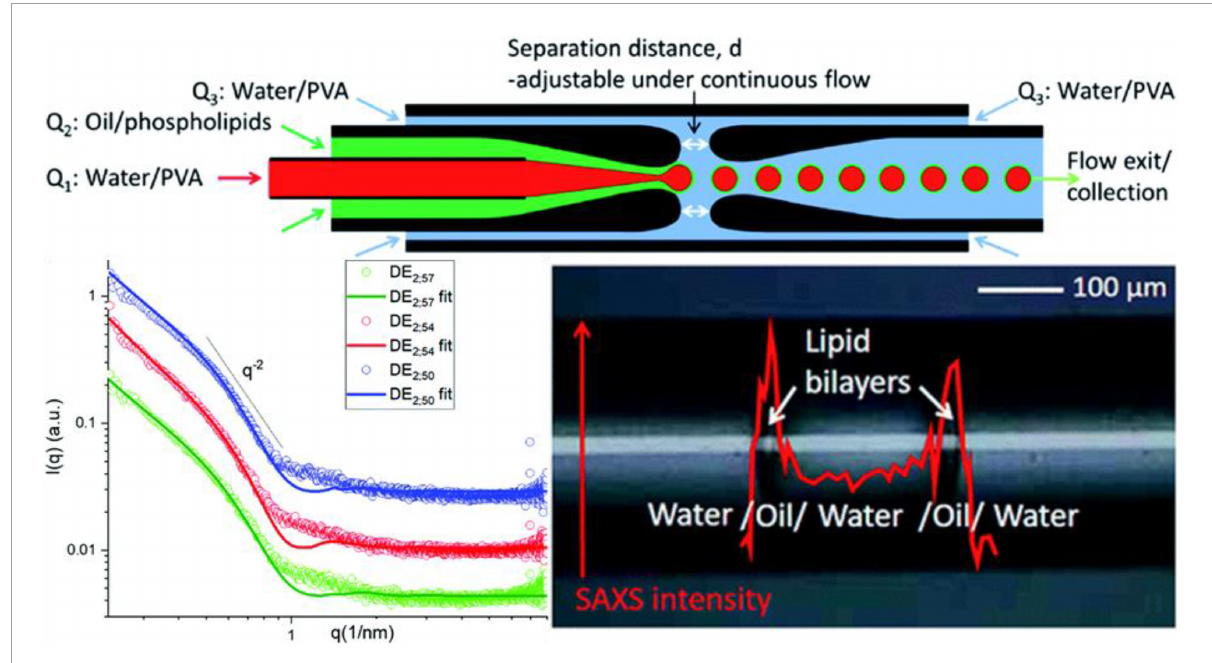
FIGURE7 (Top) Setup of the microfluidic small-angle X-ray scattering (SAXS) device. (Bottom left) SAXS profiles of the w/o/w double emulsion interfaces obtained using the microfluidic device (RT; green), after storage at 50 ◦ C for 120 min (red) and for 240 min (blue), respectively. (Bottom right) Scheme of SAXS intensity at q = 0.9 nm - 1 recorded along an axial line covering a whole double emulsion unit. Reproduced from Clemente et al. (102).